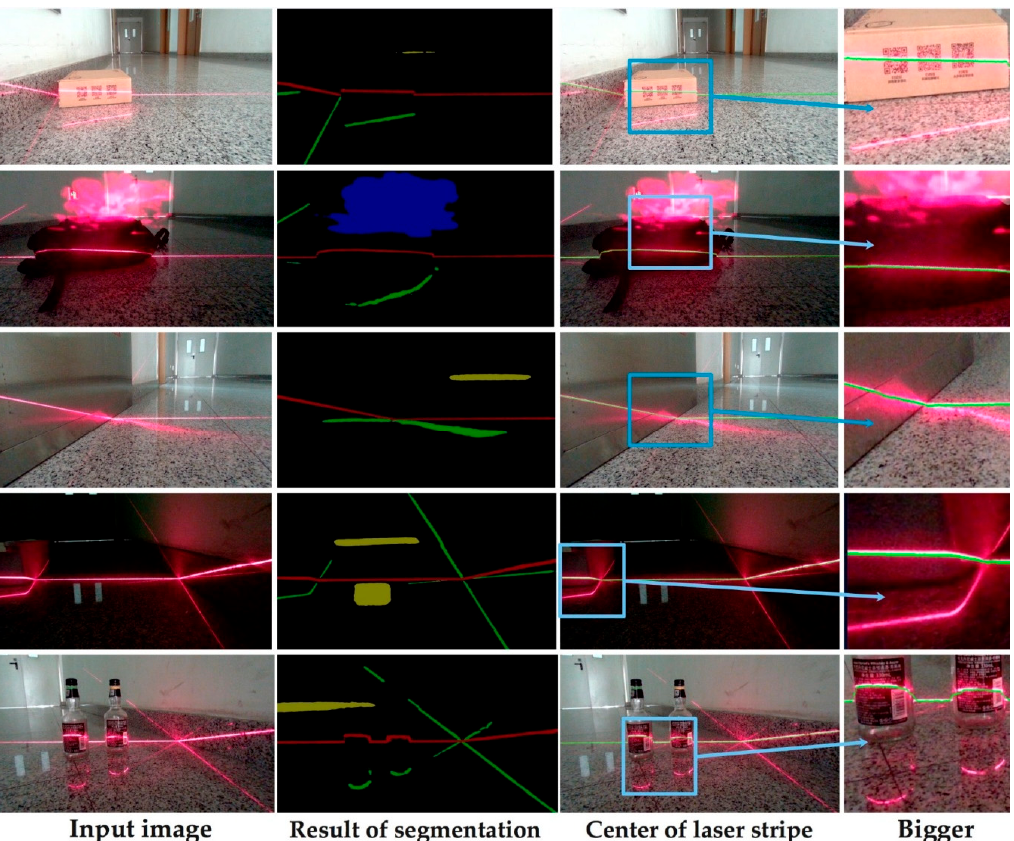
Figure 11. Results of segmentation and extraction dealing with different noises. The input image (1920 × 1920 pixels). The middle column is the output of our network, where different colors denote different categories. The right column is the result of the center extraction based on the segmentation. The laser stripe’s center is marked as green.